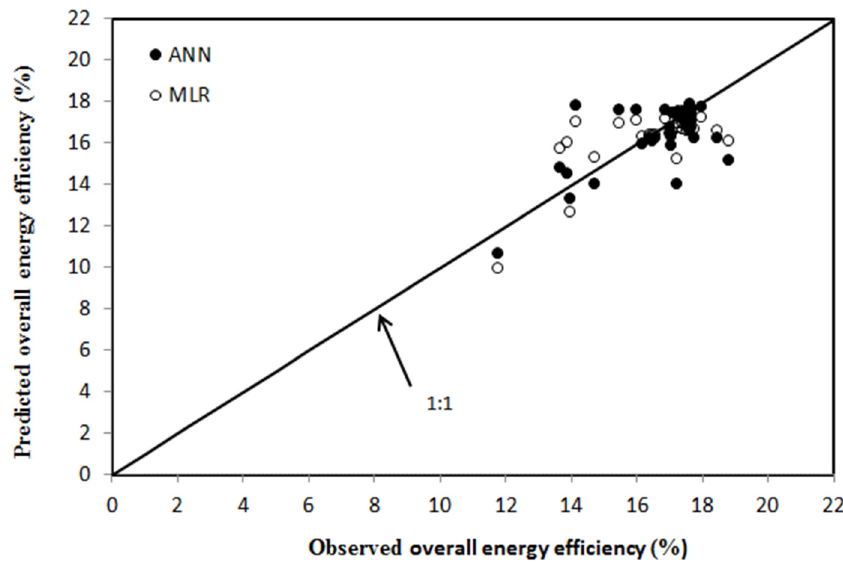
Figure 9. Correlation between the observed and predicted values for the overall energy efficiency of the MLR and ANN models in the case of the testing dataset.